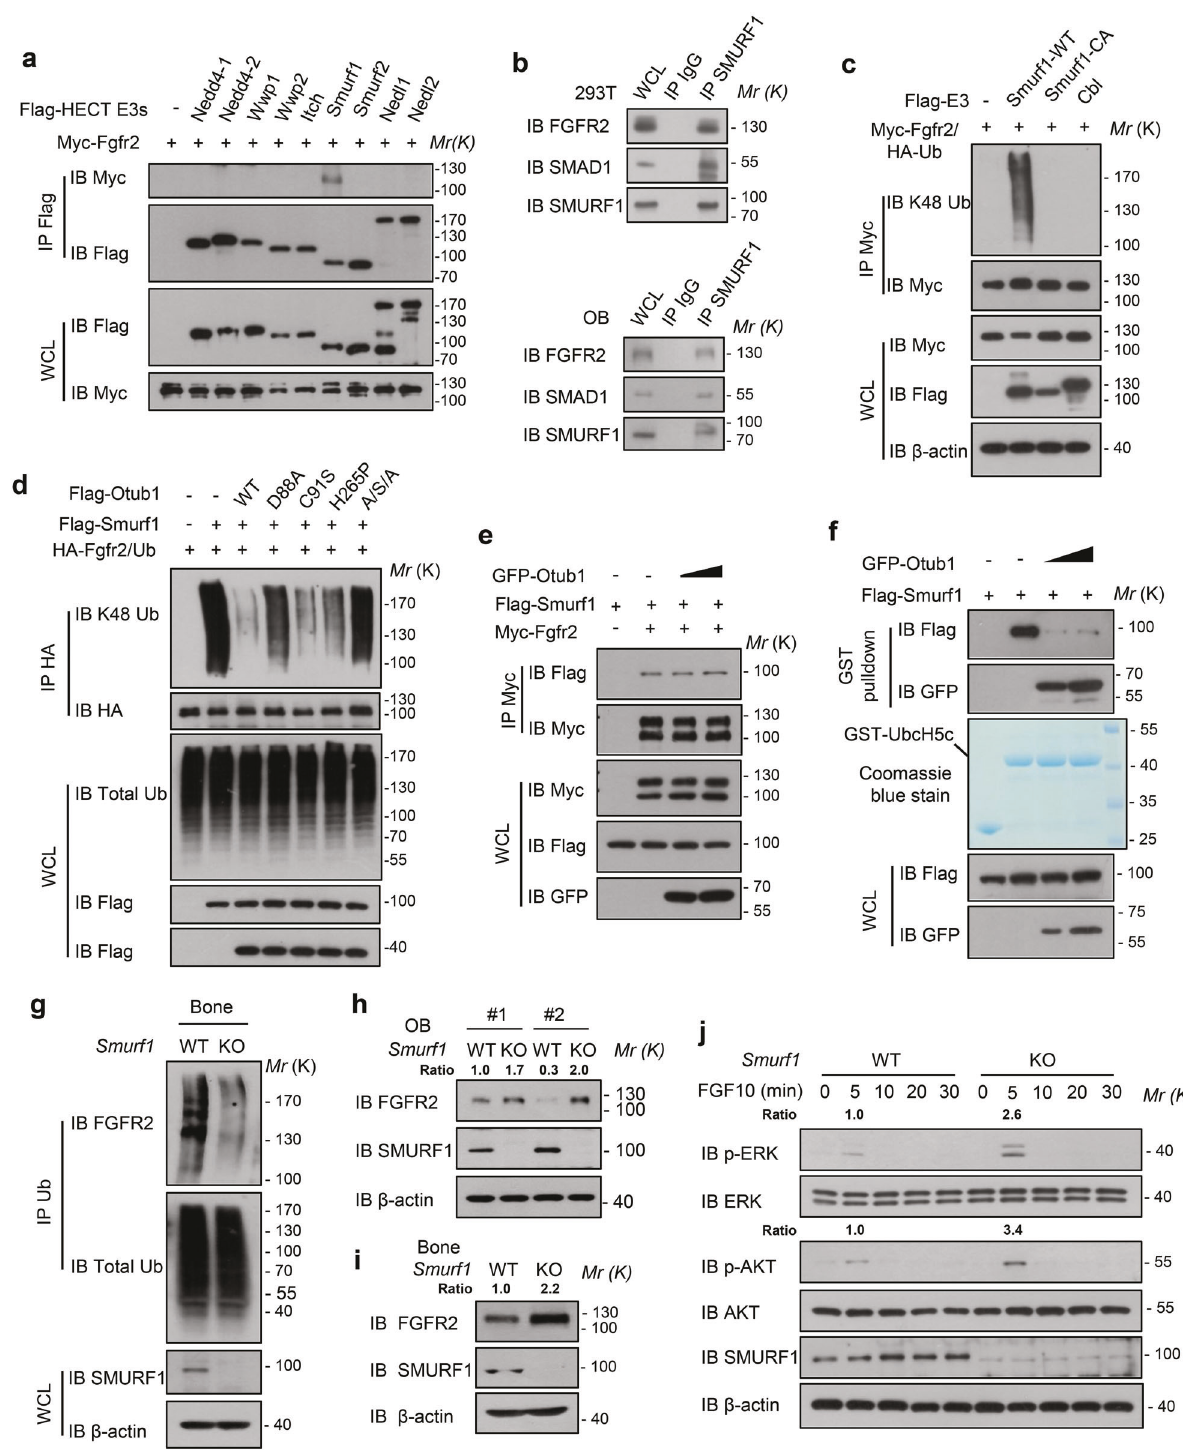
Fig. 4 OTUB1 cooperates with SMURF1 to regulate the ubiquitination and stability of FGFR2. a Immunoprecipitates of Nedd4 family proteins in HEK293T cells transfected with Myc-Fgfr2 and immunoblotted with the indicated antibodies. b Examination of in vivo interaction between SMURF1 and OTUB1 in HEK293T and osteoblast cells. c Immunoprecipitates of FGFR2 ubiquitination in HEK293T cells transfected with Flag- Smurf1-WT, Flag-Smurf1-CA, and Flag-Cbl, and immunoblotted with the indicated antibodies. d Immunoprecipitates of FGFR2 ubiquitination in HEK293T cells transfected with Flag-Smurf1 or indicated Flag-Otub1 (WT, D88A, C91S, H265A, and A/S/A) and immunoblotted with the indicated antibodies. e Immunoblot analysis of the interaction between SMURF1 and its substrate FGFR2 in HEK293T cells with or without GFP-Otub1. f Immunoblot analysis of the interaction between SMURF1 and its E2 UbcH5c in vitro. g Immunoblot analysis of the ubiquitination of FGFR2 in bones from Smurf1 + / + and Smurf1 − / − mice. h Immunoblot analysis of FGFR2 expression in Smurf1 + / + and Smurf1 − / − osteoblast (OB) cells. i Immunoblot analysis of FGFR2 expression in Smurf1 + / + and Smurf1 − / − bones. j Immunoblot of the signaling proteins including PI3K and MAPK signaling in Smurf1 WT and KO osteoblast cells with 20 ng/ml FGF10 stimulation